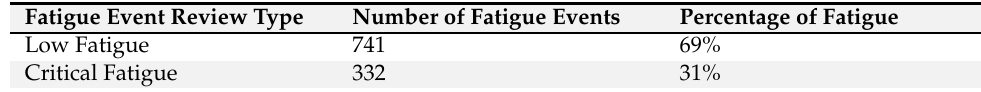
Table 2. Count and percentage of fatigue event by